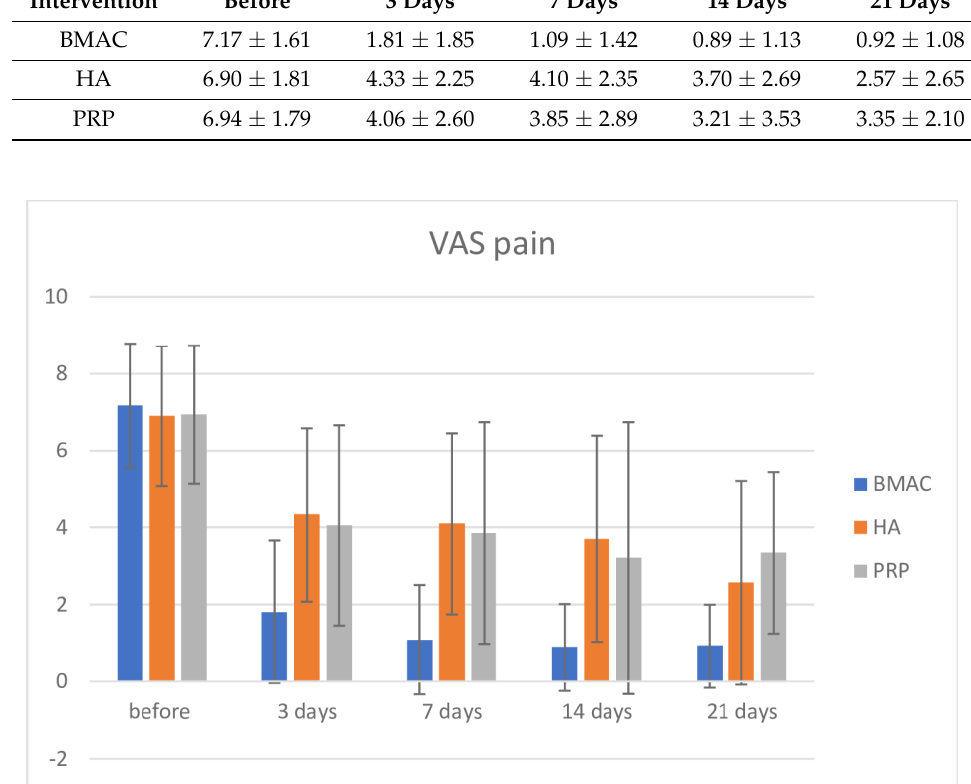
Figure 2. Visual Analog Scale pain before intervention and after 3, 7, 14, and 21